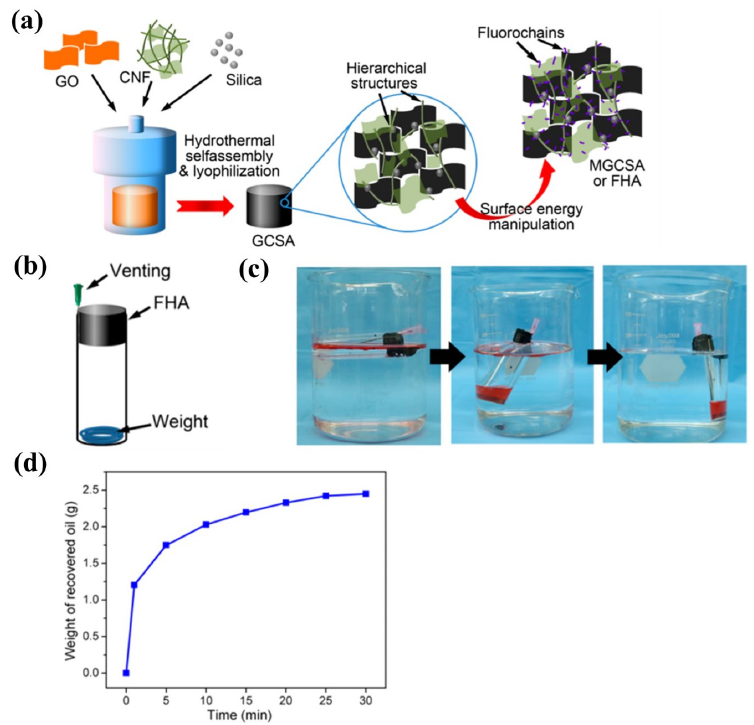
Figure 9. ( a ) Schematic illustration of the GO/CNF/Si aerogel (or FHA) fabrication process. ( b ) Illustration of the device developed for oil collection. ( c ) Photos demonstrating the oil col- lection process. ( d ) Weight of recovered oil over time with the developed device in ( b ). Reproduced with permission [91]. Copyright 2018, American Chemical Society.